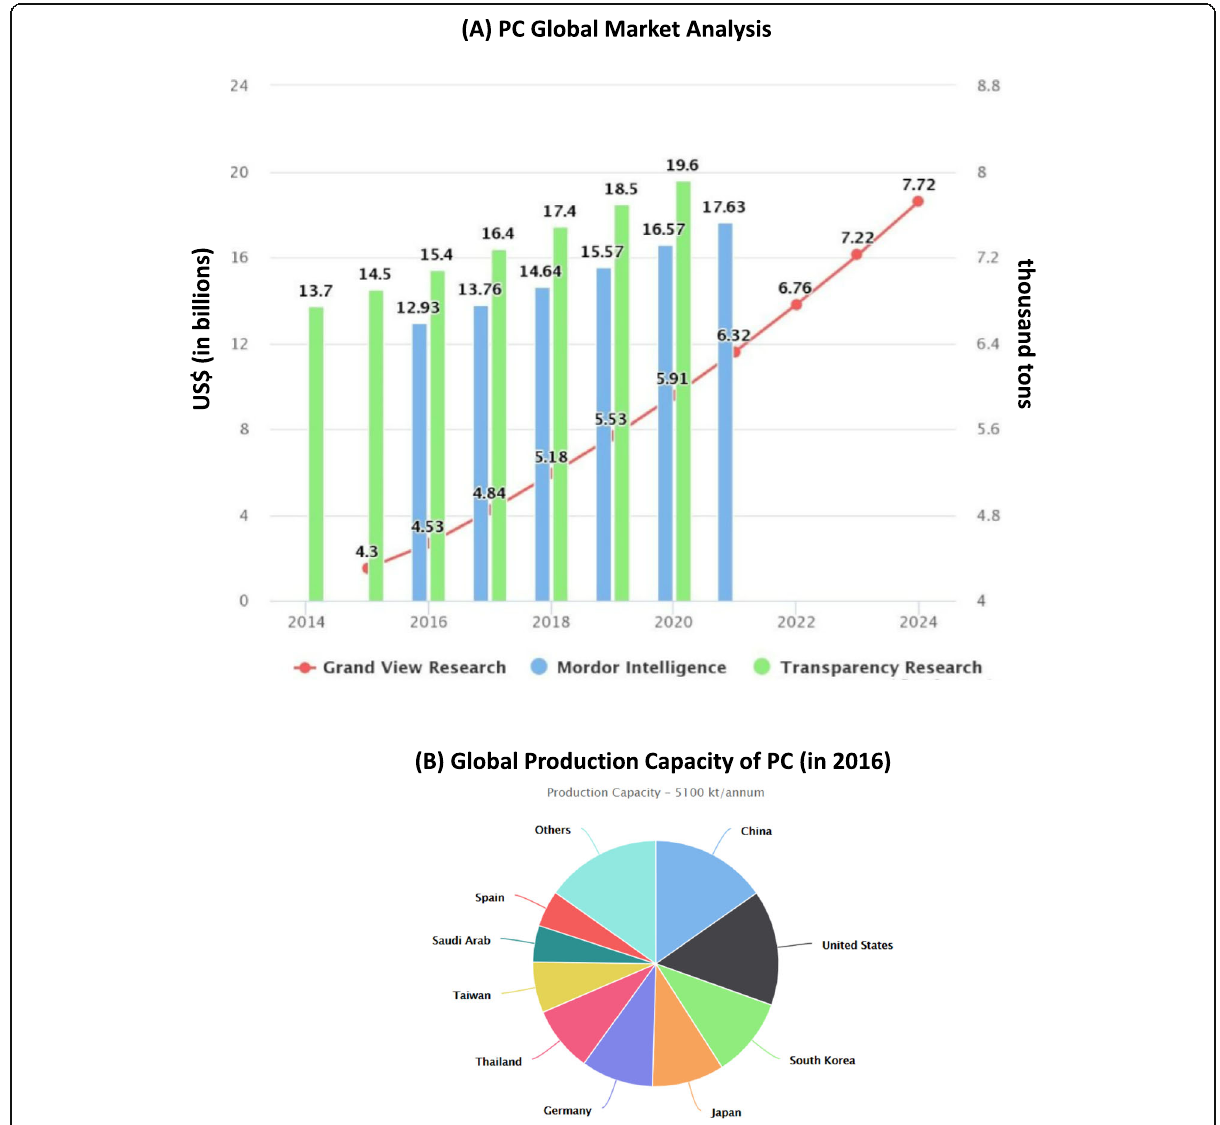
Fig. 2 (A) Market analysis of PC as obtained from different sources: market value (left axis) and demand (right axis) vs. years (2014 – 2024); ( B ) Global production capacity of PC. Courtesy of Plastic Insights from reference